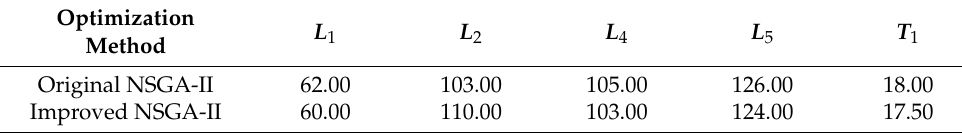
Table 8. Comparison of optimization results.